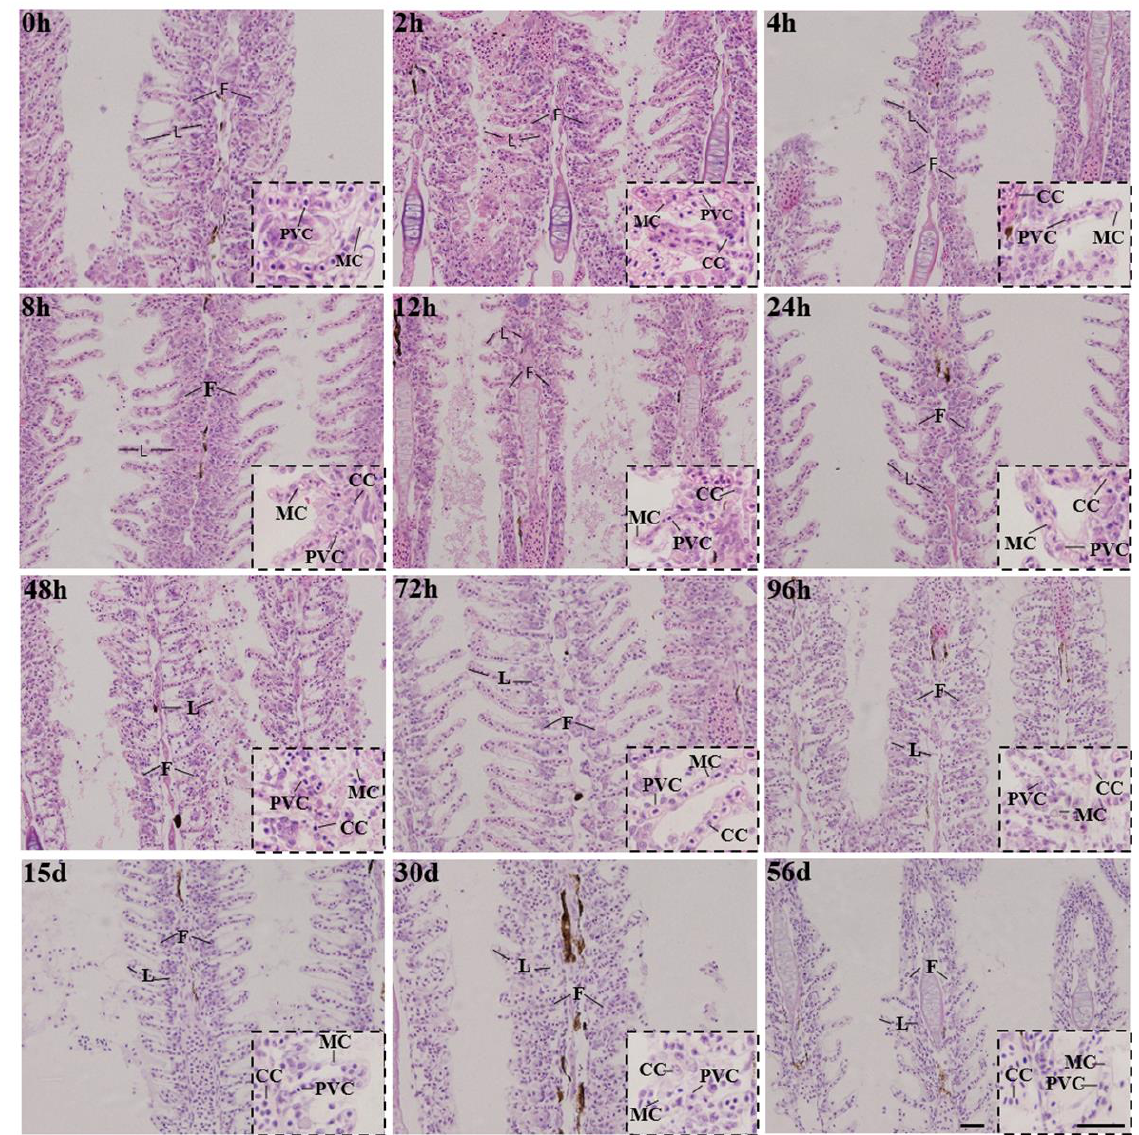
Figure 2. Histological structure of gill tissue of silver carps exposed at 6 ppt salinity. F: gill filament, L: gill lamellae, CC: chlorine cell, PVC: pavement cell, MC: mucous cell.